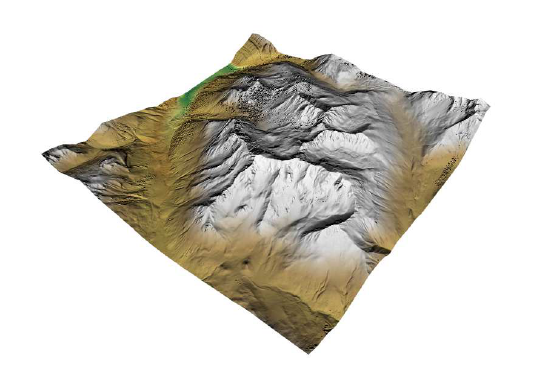
Figure 10: 3D View of the Combeynot Peaks